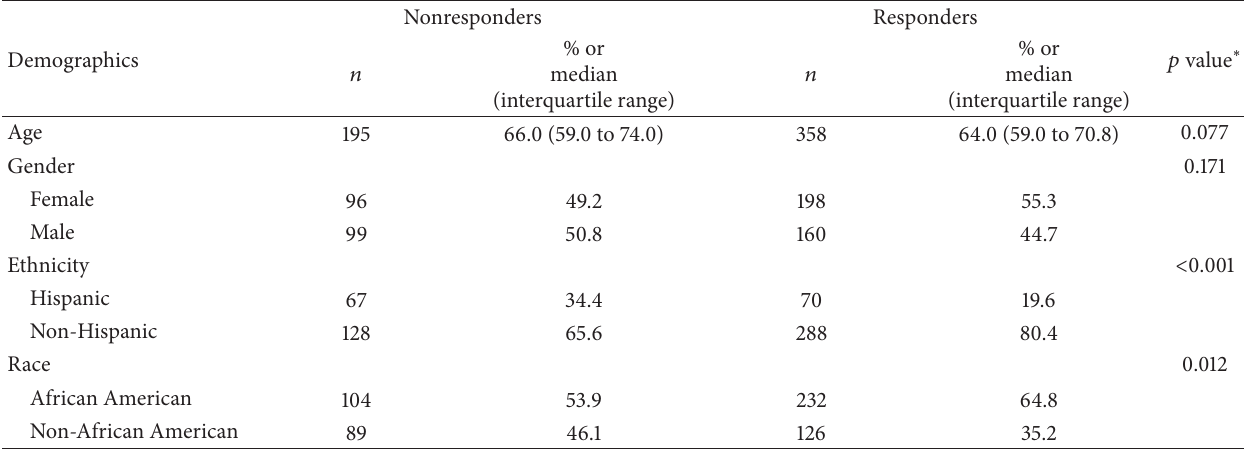
Table 1: Stage 1 responders and nonresponders by sociodemographic groupings.